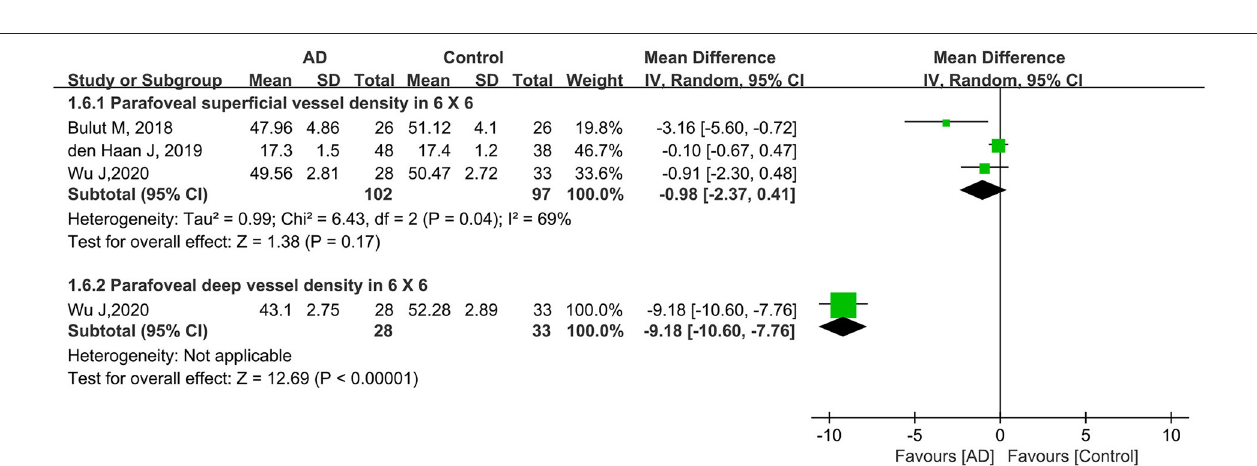
FIGURE 6 | Forest plot for parafoveal superficial and deep vessel density as measured by 3 × 3-mm scan size in AD eyes and controls.